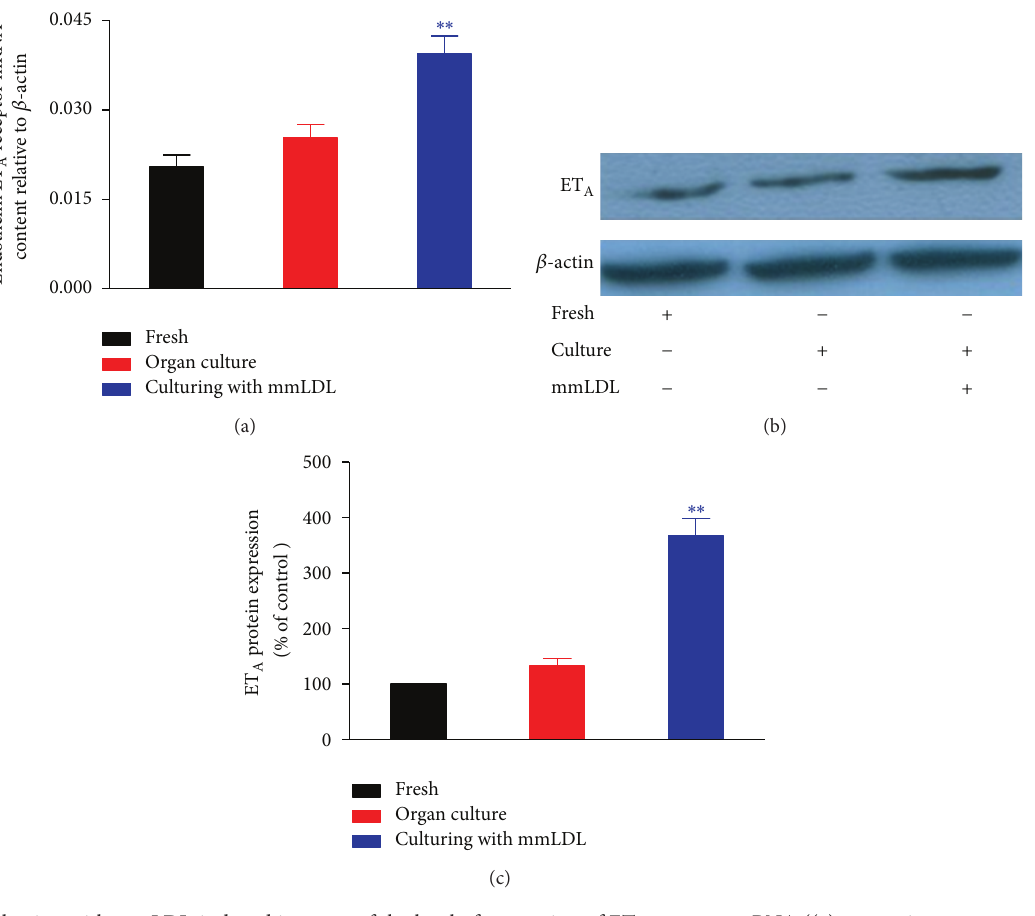
Figure 2: Culturing with mmLDL-induced increase of the level of expression of ET A receptor mRNA ((a) 𝑛 = 5 -6 coronary arteries, from that number of animals) and protein ((b and c) 𝑛 = 4 samples, each sample being a pool of 4 coronary arteries). The data are presented as the mean ± SEM. ∗∗ 𝑃 < 0.01 versus organ culture.